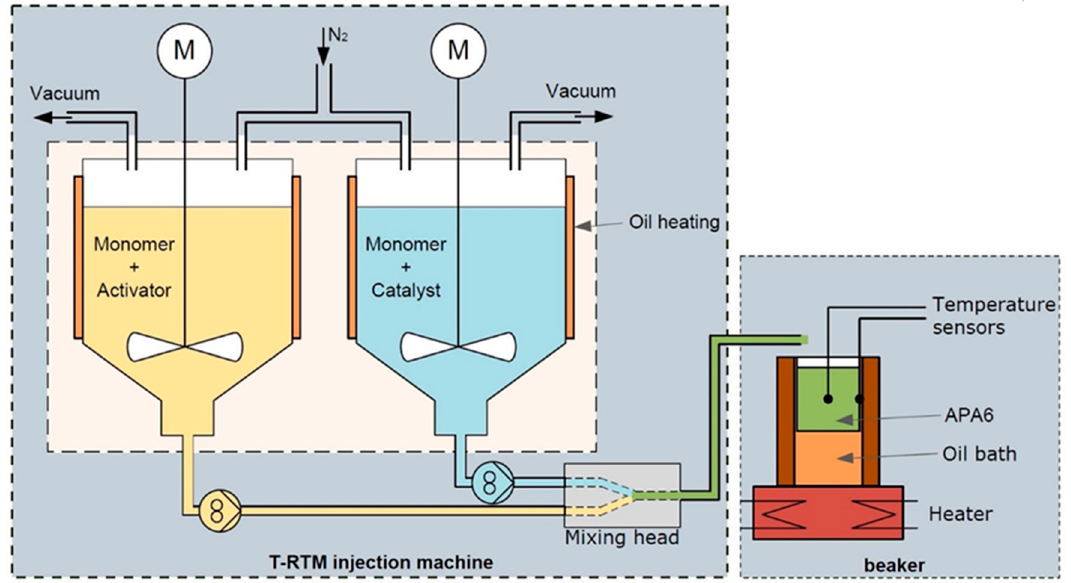
Figure 5. Schematic setup of low pressure T-RTM injection machine and beaker for the kinetic